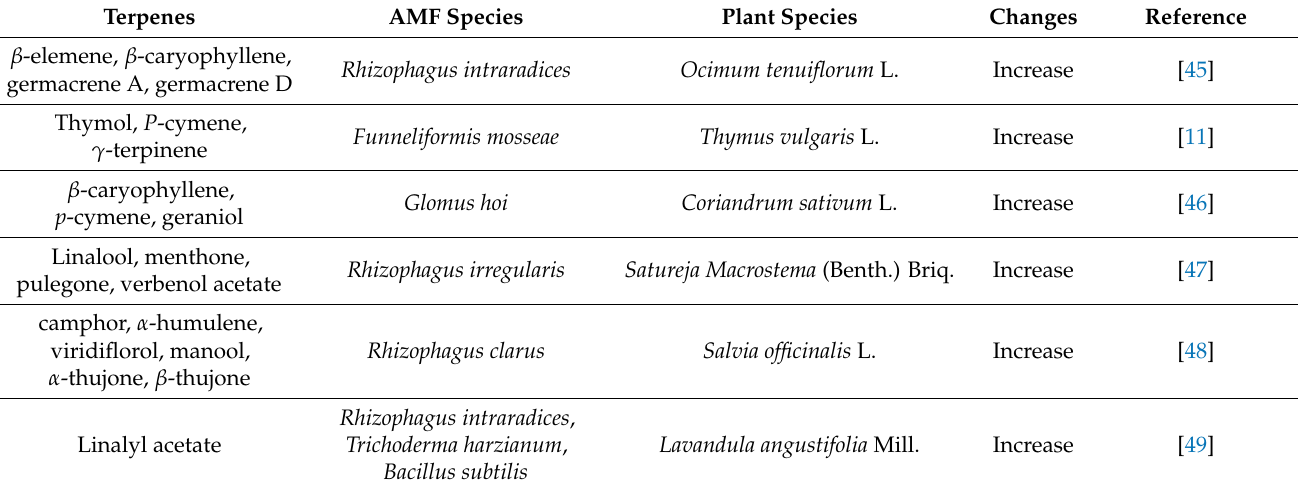
Table 2. Effects of different AMF species on the terpenoids content of medicinal and aromatic